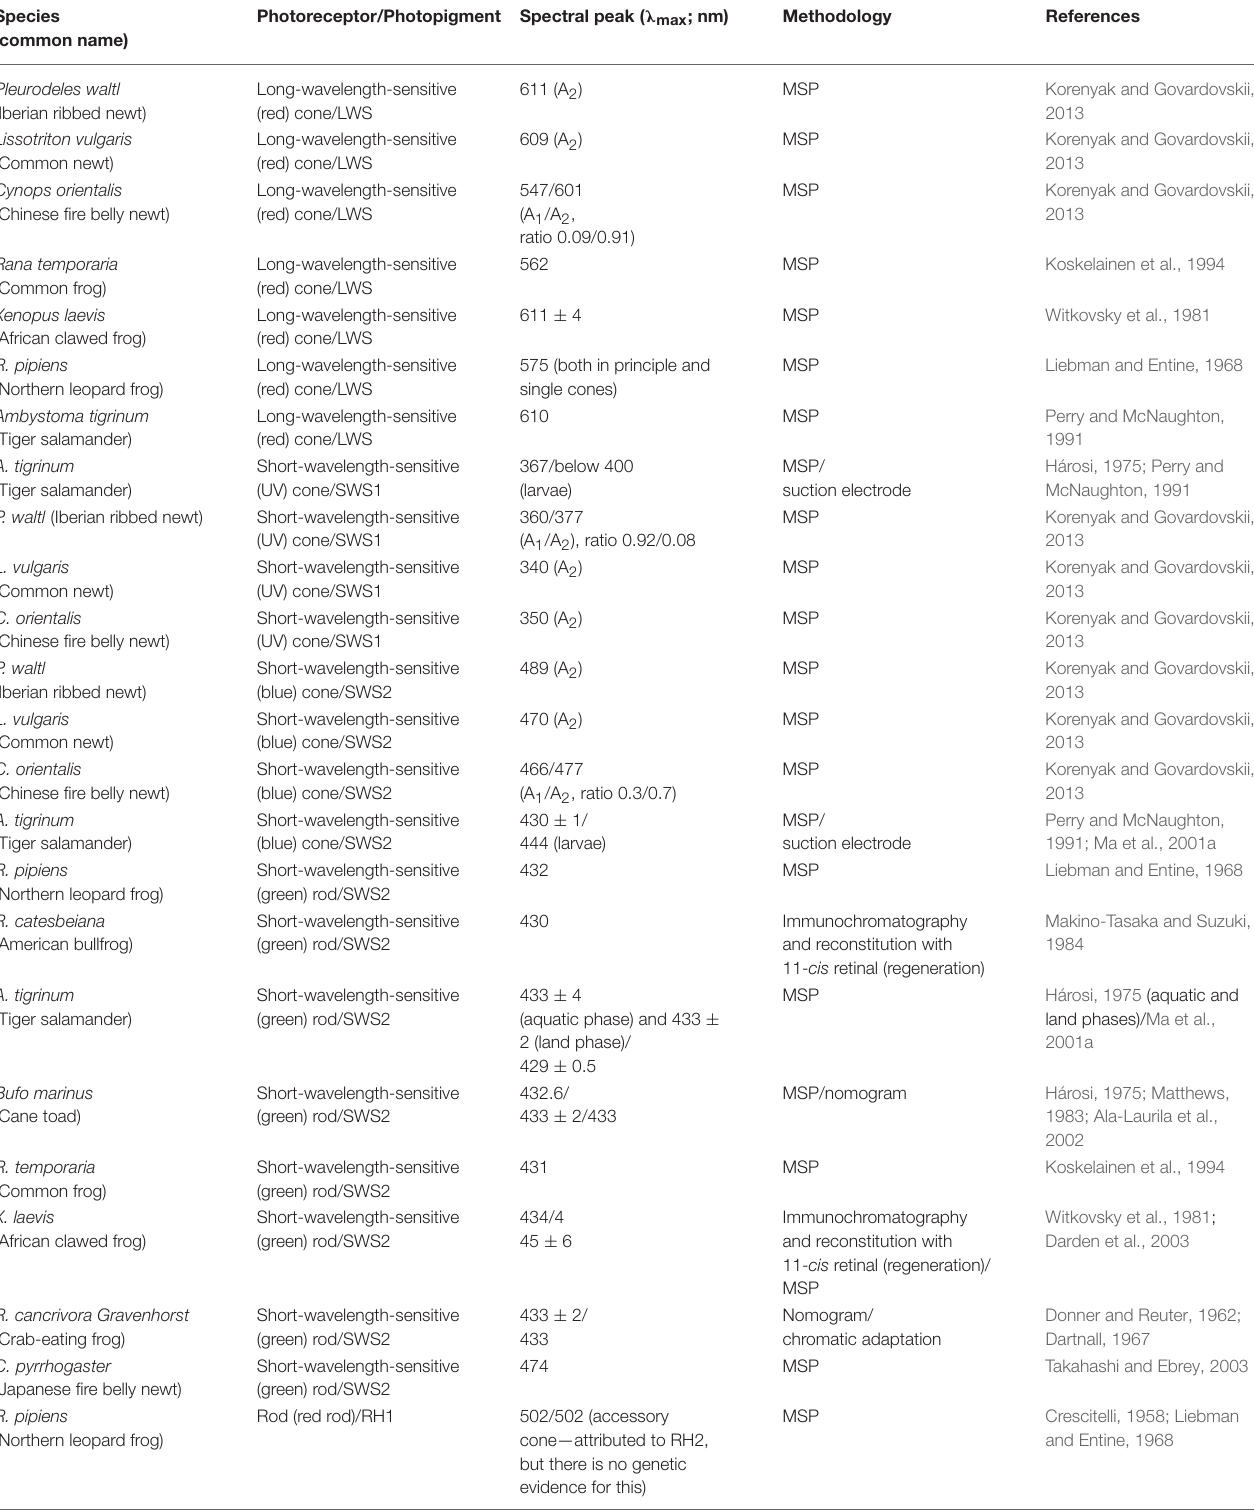
TABLE 1 | Spectral absorbance peaks ( λ max ) and methodologies used for an array of different amphibian rods (red- and green-sensitive) and cones (blue- and UV-sensitive), with expressed photopigments and their chromophore usage indicated). Species (common